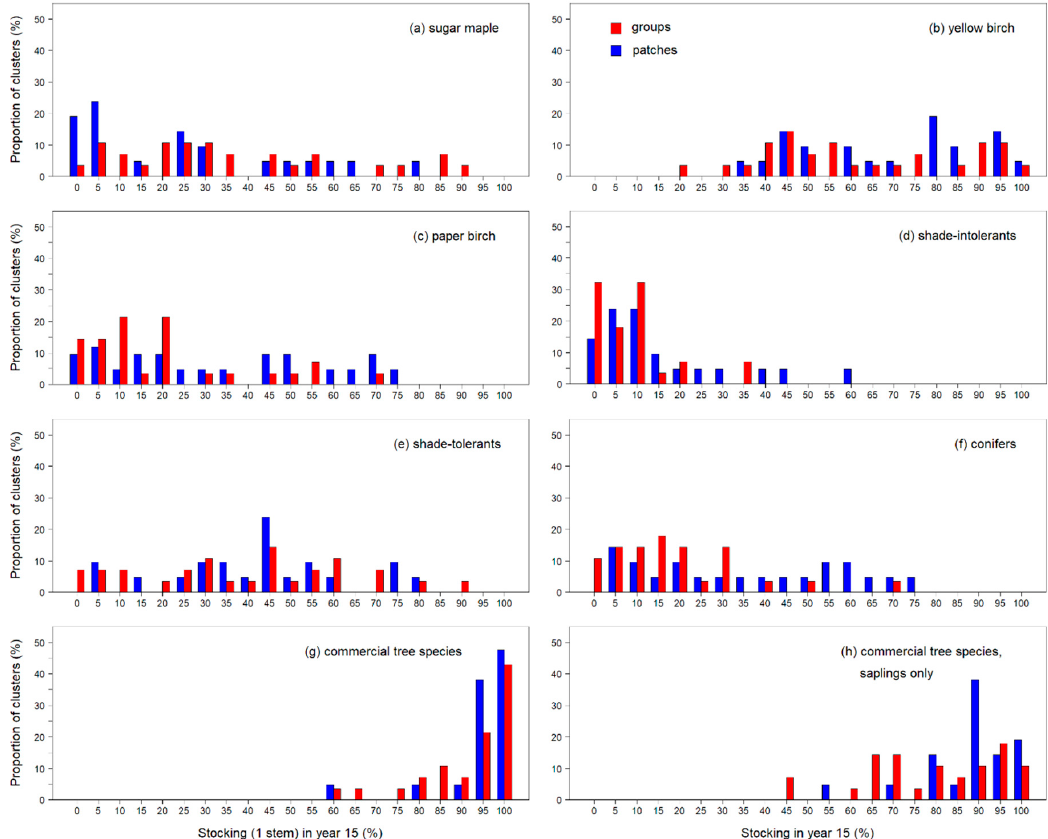
Figure 2. Regeneration stockings, calculated on 6.25-m 2 quadrats and considering all seedlings and saplings, for commercial tree species within canopy openings (groups, red, or patches, blue) 15 years after harvest. Data are cluster means, shown separately ( a – h ) per species or species pool (see Table 1). Units on the x -axis represent the upper end of classes of five points of percentage, i.e., 100 is ]95–100], 95 is ]90–95], etc., but 0 is only